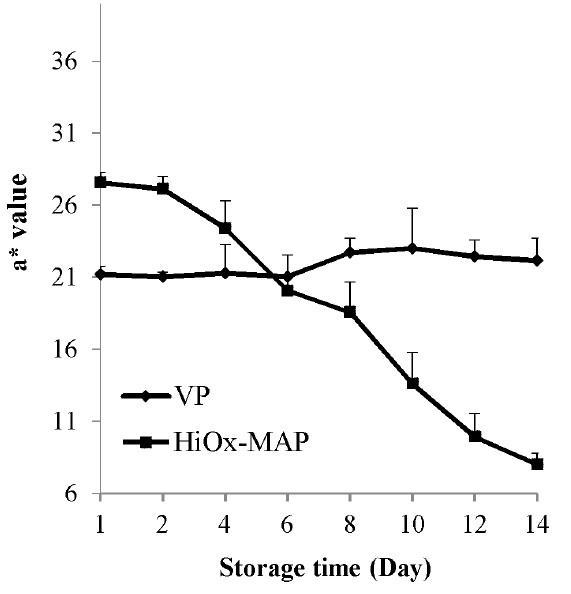
Table 2. Effects of vacuum packaging (VP) and high-oxygen modified atmosphere packaging (HiOx-MAP, 80% O